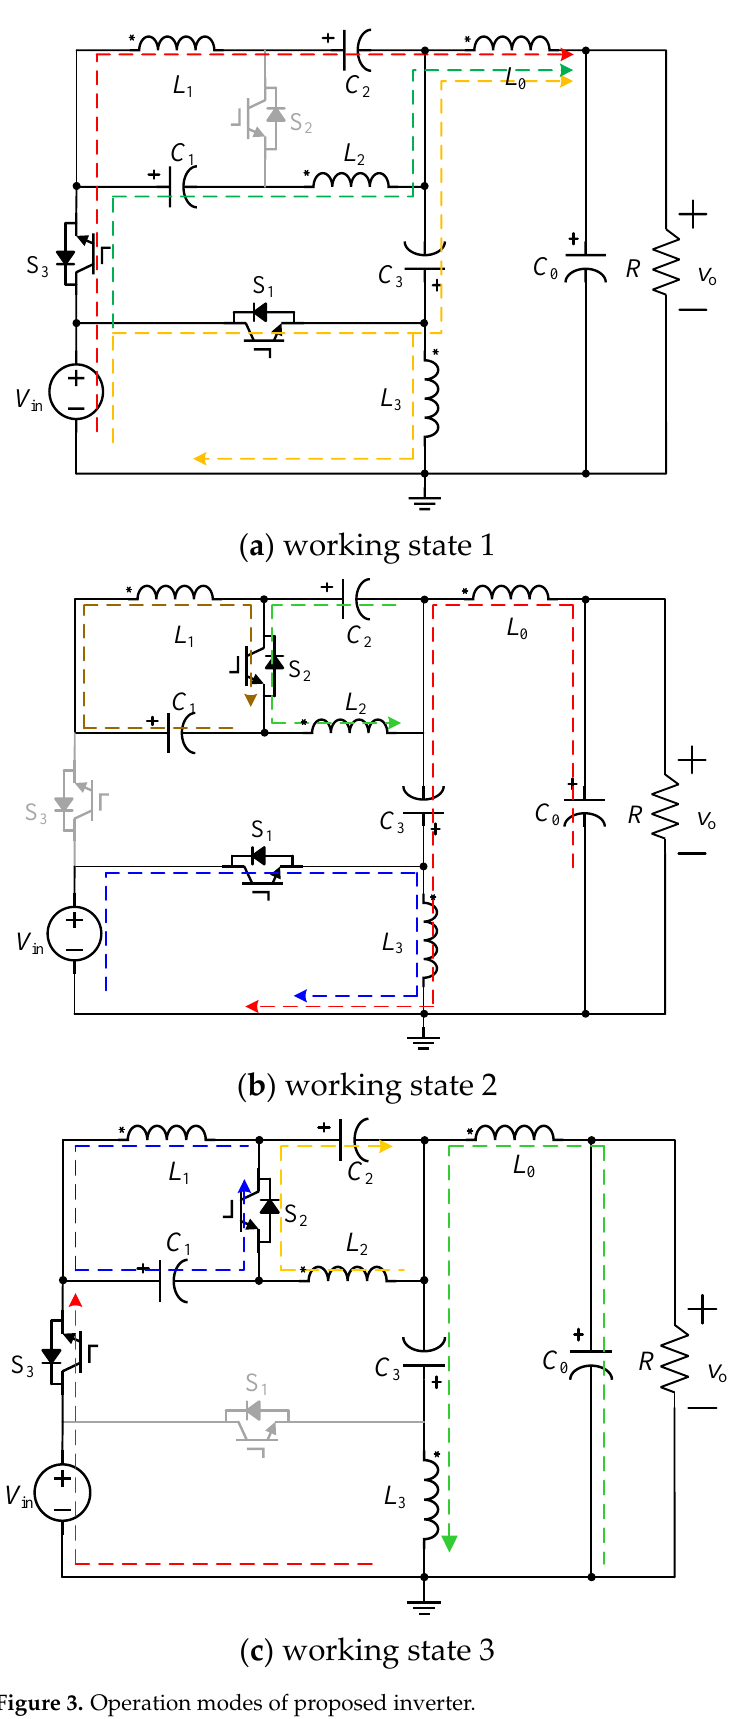
Figure 3. Operation modes of proposed inverter.